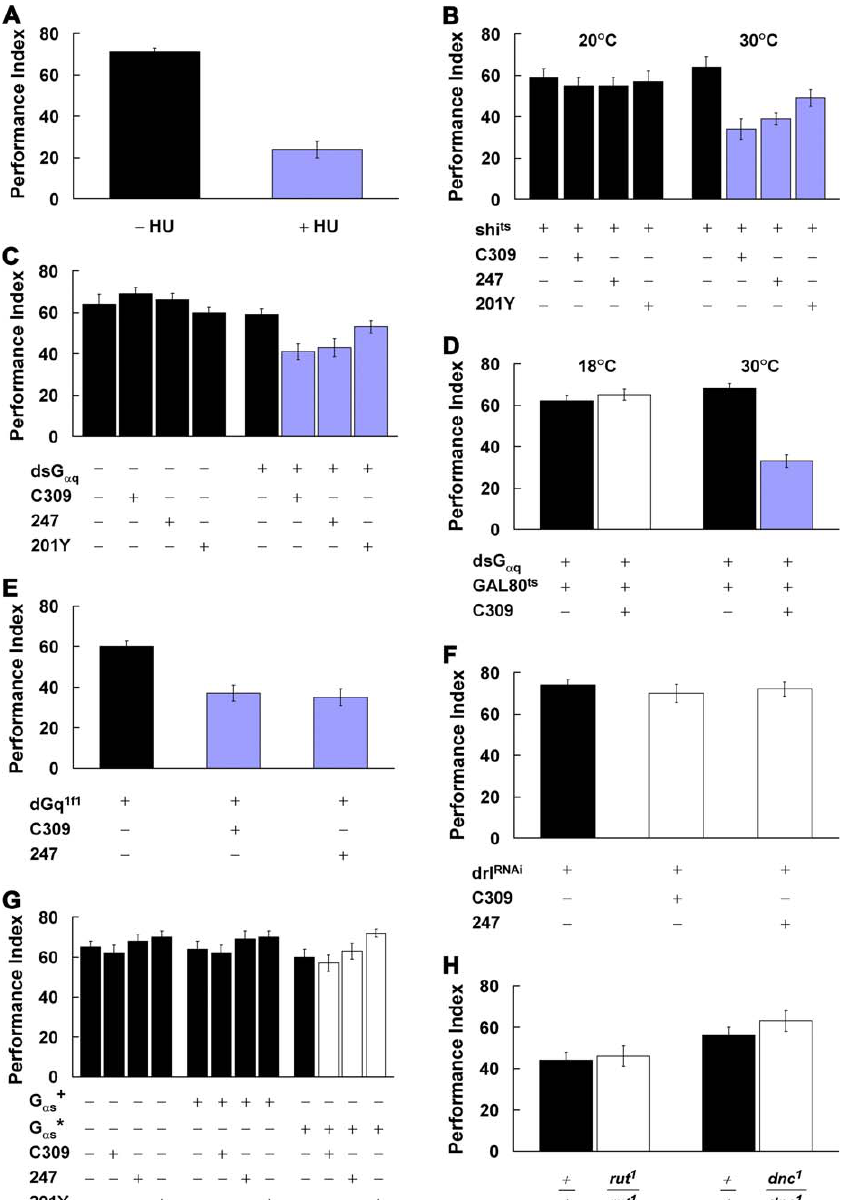
Figure 2. Spontaneous Odor Identity Discrimination Requires Synaptic Transmission from MB and Depends on G a q Signaling (A (cid:2) E) Spontaneous odor identity discrimination between MCH and BA was severely disrupted (A) by MB ablation ( þ HU), (B) by transient block (30 8 C) of synaptic transmission from MB in C309/shi ts , 247/shi ts , or 201Y/shi ts flies, (C) by developmental disruption of G a q in MB of ds G a q /C309, ds G a q /247, and ds G a q /201Y flies, (D) by adult-specific, physiological disruption of G a q in MB of ds G a q , GAL80 ts /C309 flies at restrictive (30 8 C for 3 d) but not permissive (18 8 C for 3 d) temperature, or (E) by developmental disruption of G a q in MB of dG q 1F1 /C309 or dG q 1F1 /247 flies. (F (cid:2) H) Spontaneous odor identity discrimination was not affected (F) when the drl gene was knocked down in MB via RNAi-mediated disruption (T. T., H. Tang, and M. Regulski, unpublished data) in drl RNAi /C309 or drl RNAi /247 flies, (G) when G a s was disrupted in MB of G a s */C309, G a s */247, or G a s */201Y flies, or (H) in rut and dnc mutants. n ¼ 4 PIs for all groups.